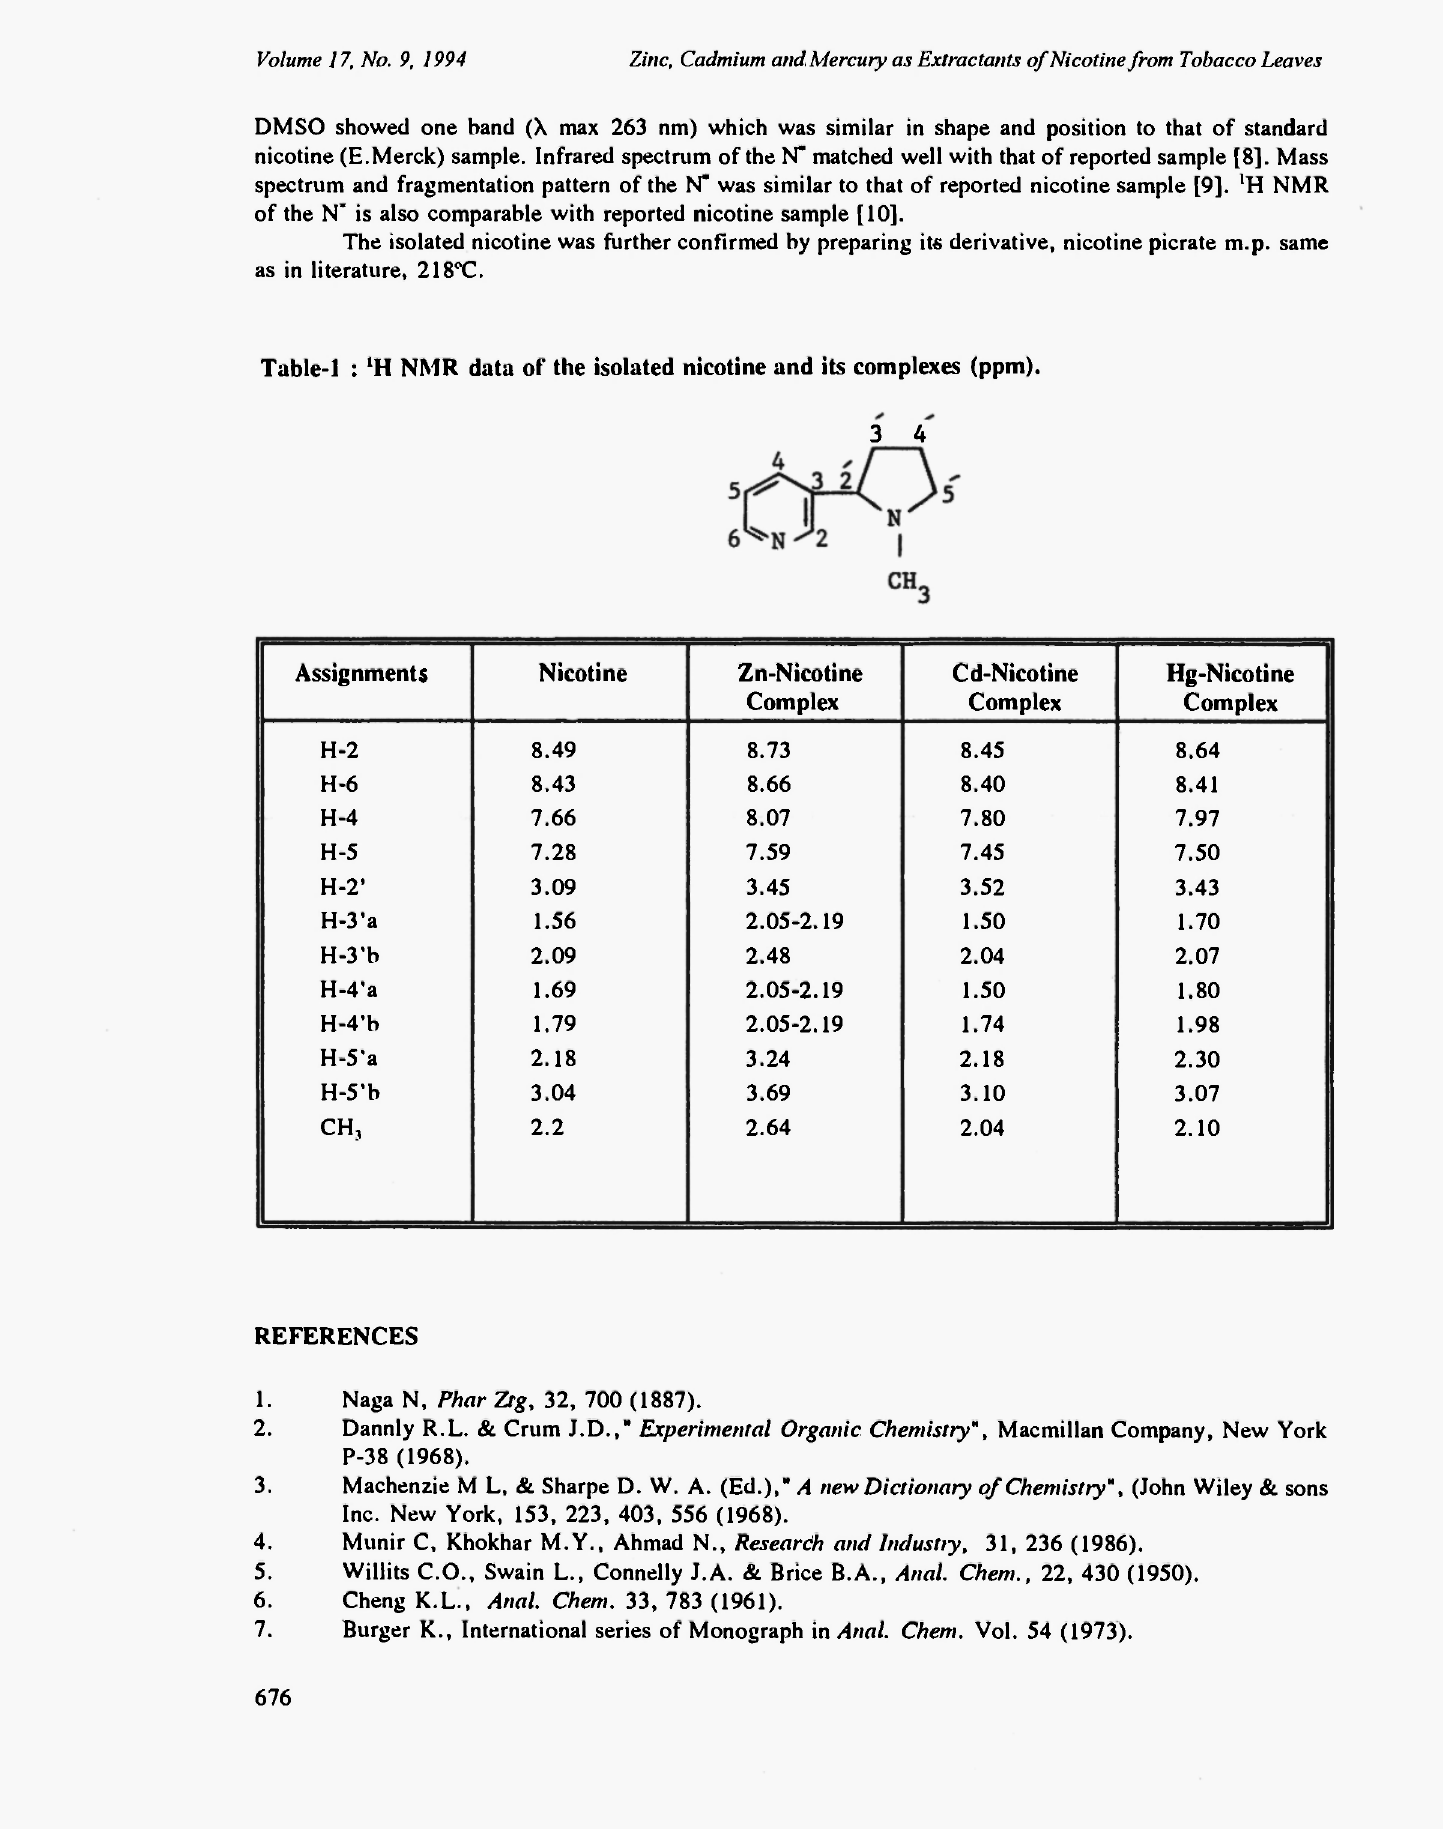
Table-1 : Ή NMR data of the isolated nicotine and its complexes (ppm).